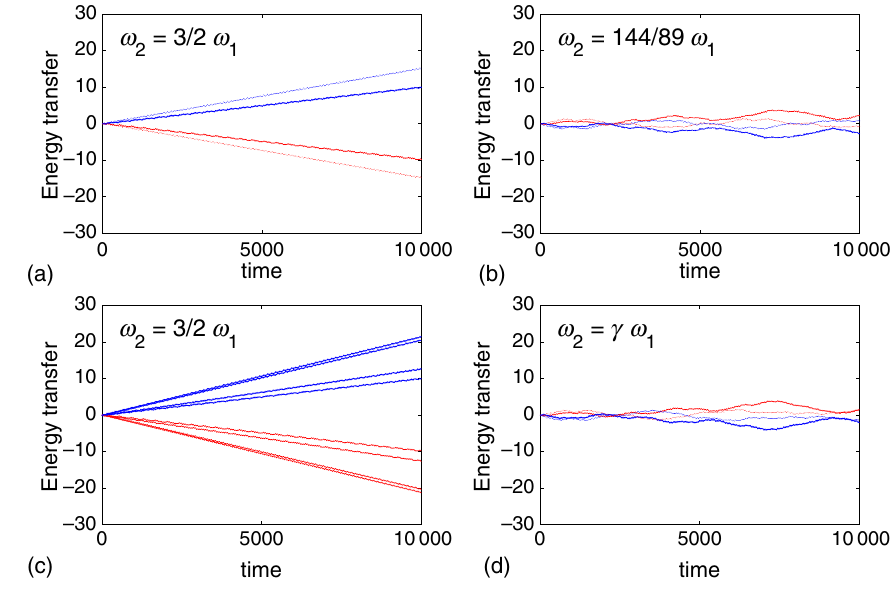
FIG. 12. Same as Fig. 10, but for η ¼ 0 . 2